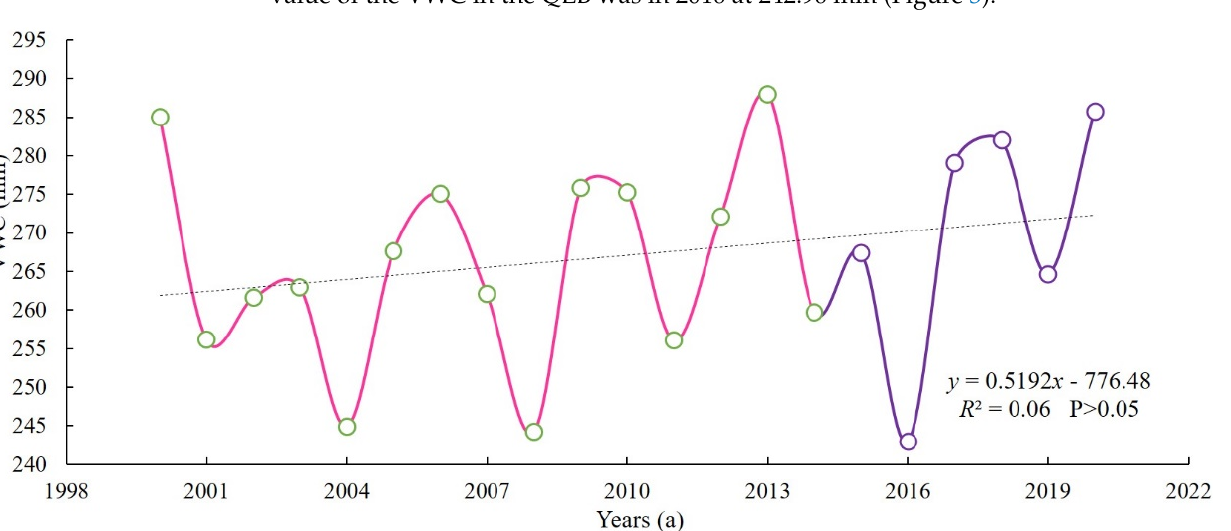
Figure 3. Change of the VWC in Qinghai Lake Basin from 2000 to 2020.